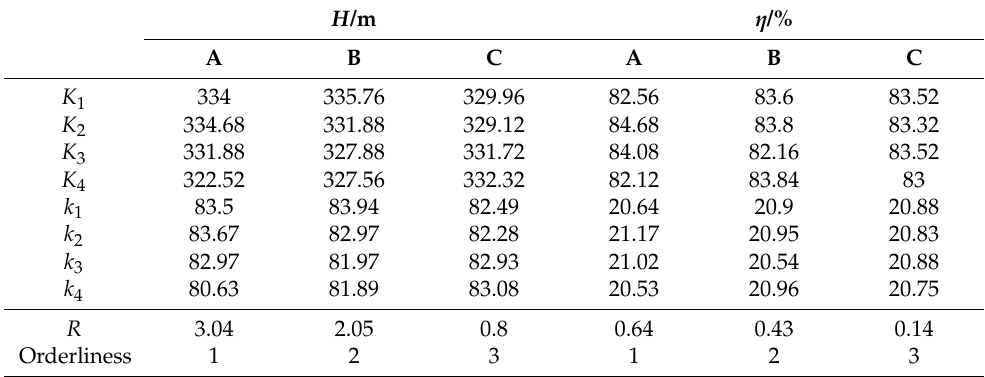
Table 6. Range analysis of the head and efficiency at 0.6 Q des .